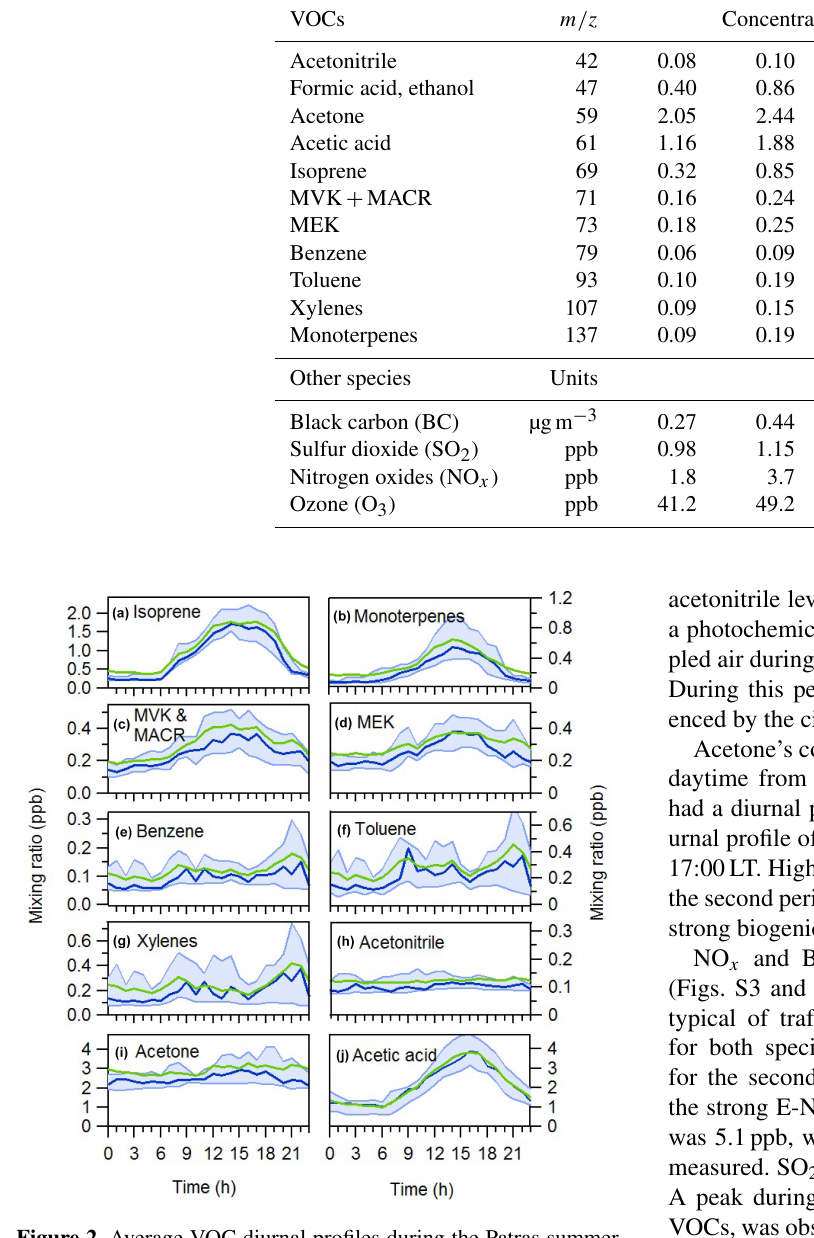
Figure 2. Average VOC diurnal profiles during the Patras summer campaign. Green lines present the average values. The median value is shown with blue. The blue area corresponds to the interquartile